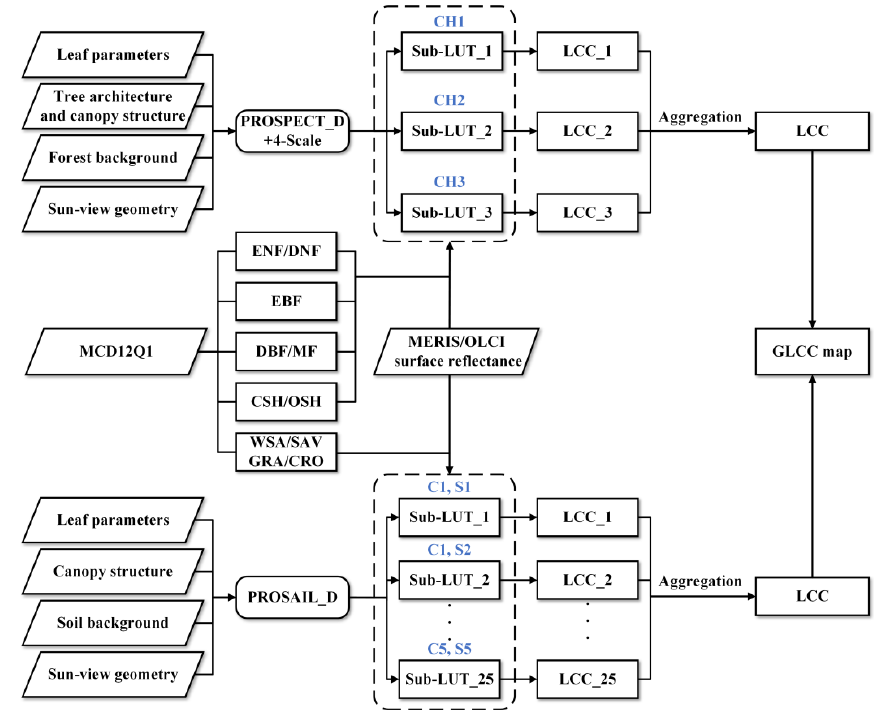
Figure 3. The flowchart of the LUT algorithm to generate GLCC dataset. CH1, CH2 and CH3 represent three types of crown height, respectively. C1 to C5 represent the canopy structures planophile, plagiophile, extremophile, spherical and uniform, respectively. S1 to S5 represent the soil backgrounds soil1, soil2, soil3, soil4 and soil5,